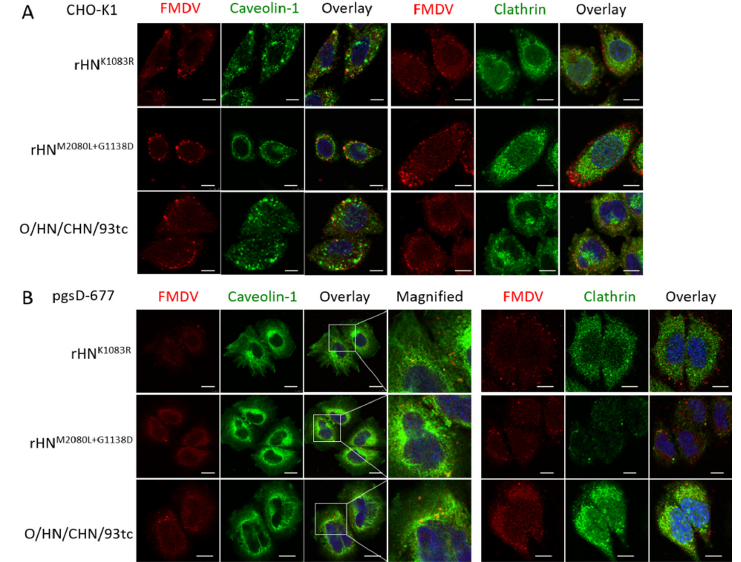
Figure 5. Analysis of the endocytic pathway of the specific FMDVs in ( A ) CHO-K1 and ( B ) pgsD-677 cells. The detailed procedures of immunofluorescence and confocal microscopy for the entry of O/HN/CHA/93tc, rHN M2080L+G1138D and rHN K1083R into these two non-integrin CHO cell lines were processed as described in the Materials and Methods. Virus (red), and clathrin (green) or caveolin-1 (green) upon entering the cell were probed after a shift to 37 °C for 15 min. Scale bars = 10 μ m.